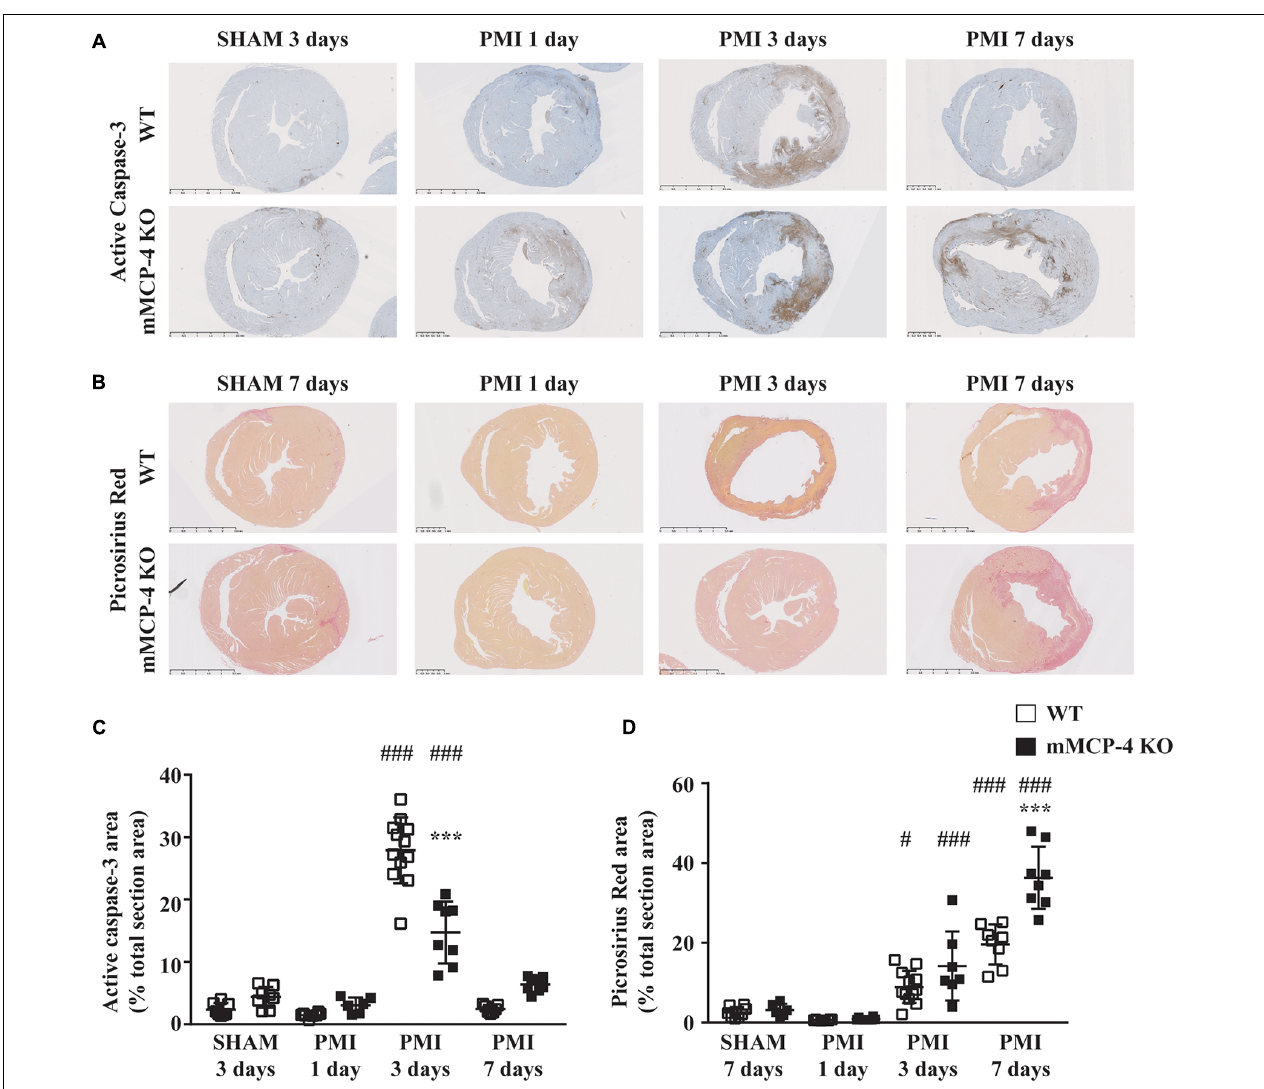
FIGURE 4 | Representative active caspase-3 (A) and collagen deposition (B) of heart sections following LAD coronary artery ligation or SHAM surgery. Active caspase-3 DAB (brown) staining [quantified in (C) ] is visible against the hematoxylin (blue) counterstain, while collagen deposition [quantified in (D) ] is marked by the picrosirius red stain. (#: PMI vs. SHAM, ∗ : mMCP-4 KO vs. WT, one-way ANOVA with multiple comparisons Holms-Šidak